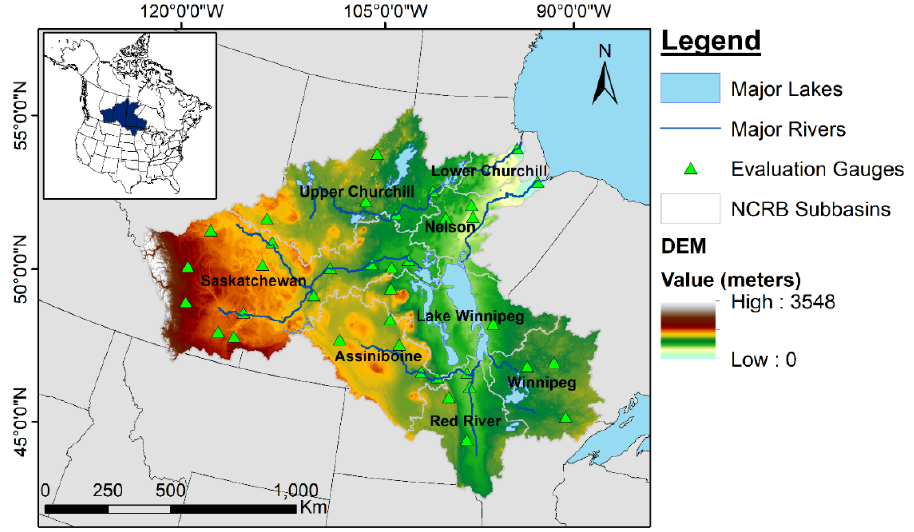
Figure 1. Map of the Nelson Churchill River Basin with major sub-basins, rivers, lakes and evaluation gauges used for sensitivity analysis.